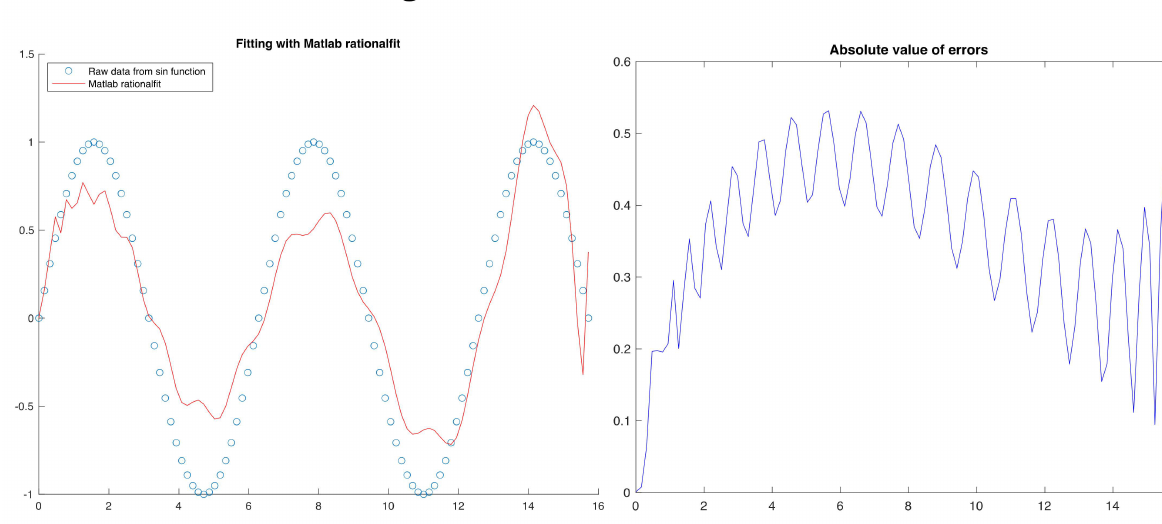
Figure 12. Fitting same discrete sample of 201 uniformly selected datapoints from sine function over [ 0, 5 π ] with MATLAB rationalfit. Residual errors are significant over most of points in [ 0, 5 π ] .